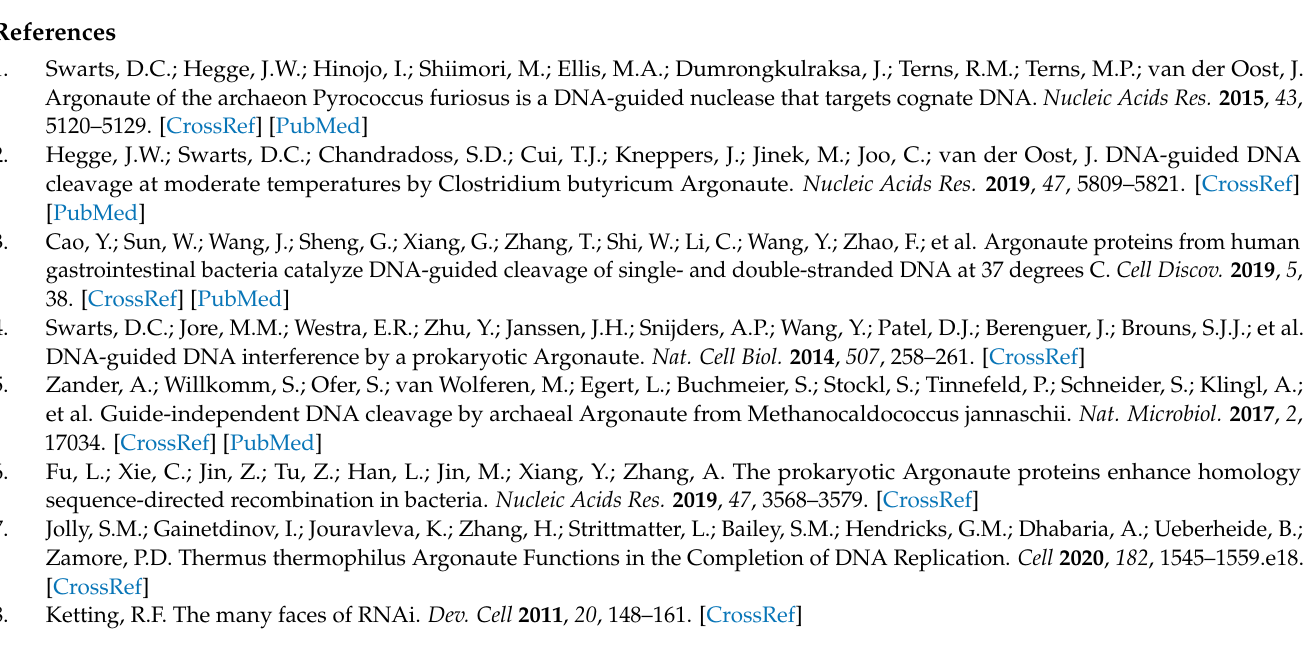
plasmid with different treatments; Figure S2: Full-length agarose gel electrophoresis result of pET28a plasmid with different treatments; Figure S3: Full-length agarose gel electrophoresis result of pET28a- TtAgo plasmid with different treatments; Figure S4: Linear representation of the 4 domains and 2 linkers of the TtAgo protein; Figure S5: Full-length western blotting images of TtAgo and TtAgo mutant protein expression in BL21(DE3); Figure S6: Full-length western blotting image of TtAgo and TtAgo mutant protein expression in DH5 α ; Figure S7: Protein structural simulation figures of the rest of the TtAgo mutants; Table S1: Primers used in this experiment; Table S2: Error-prone PCR reaction